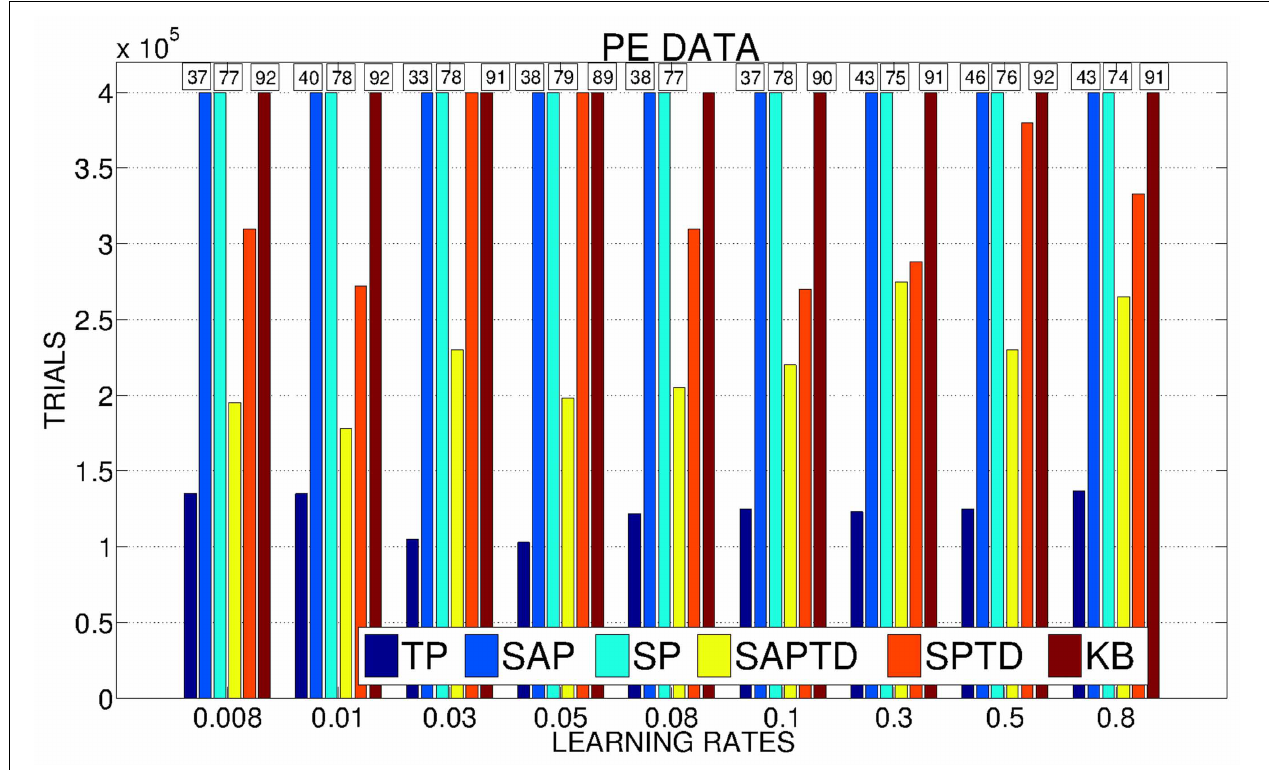
FIGURE 5 | Average number of trials needed by the system to achieve a performance in the 4 learnable tasks of 95% with different values of the learning rates of the predictors (average on